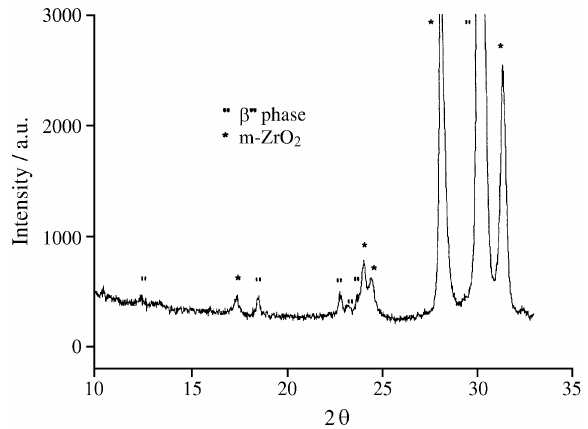
Figure 6. Diffractogram of the β ” phase between 10° and 25°. Table 2. Positions of diffraction lines for β phases.